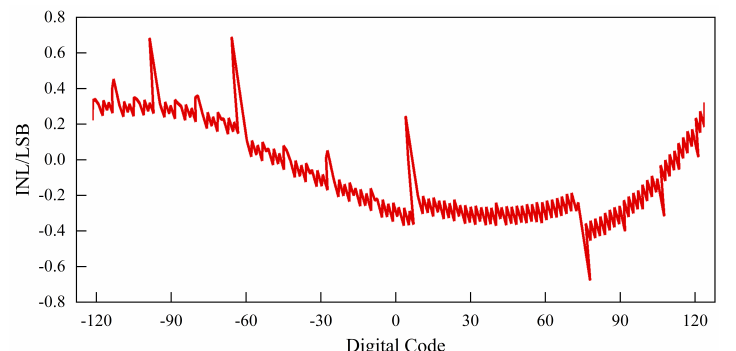
Figure 15. Differential nonlinearity.